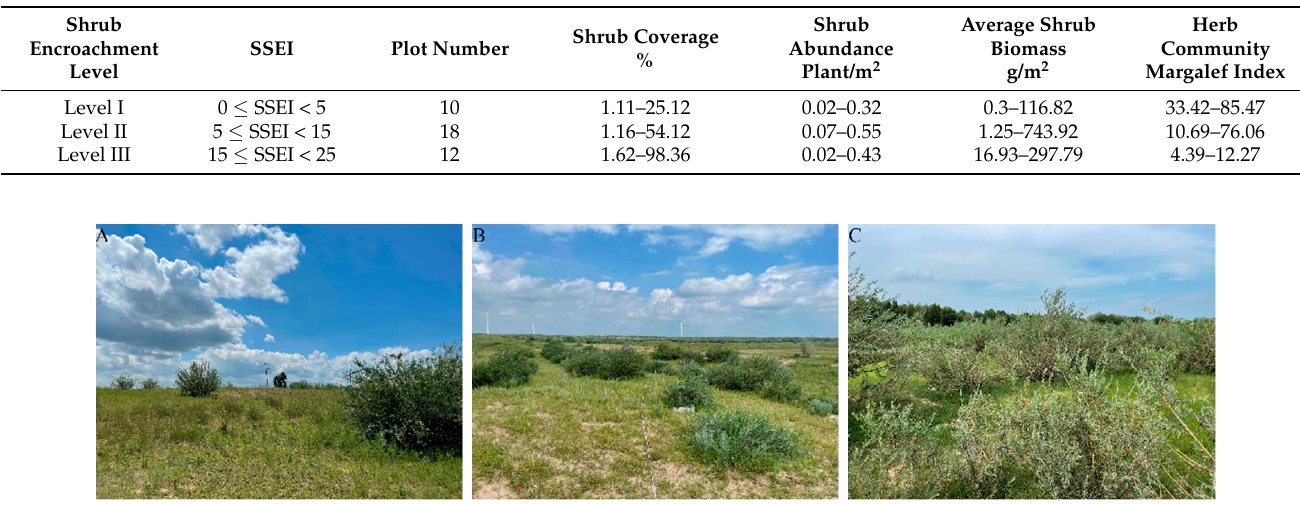
Figure 2. I-level ( A ), II-level ( B ), and III-level ( C ) shrub grasslands in the forest–grass transition zone of Inner Mongolia ( Caragana korshinskii as an example).